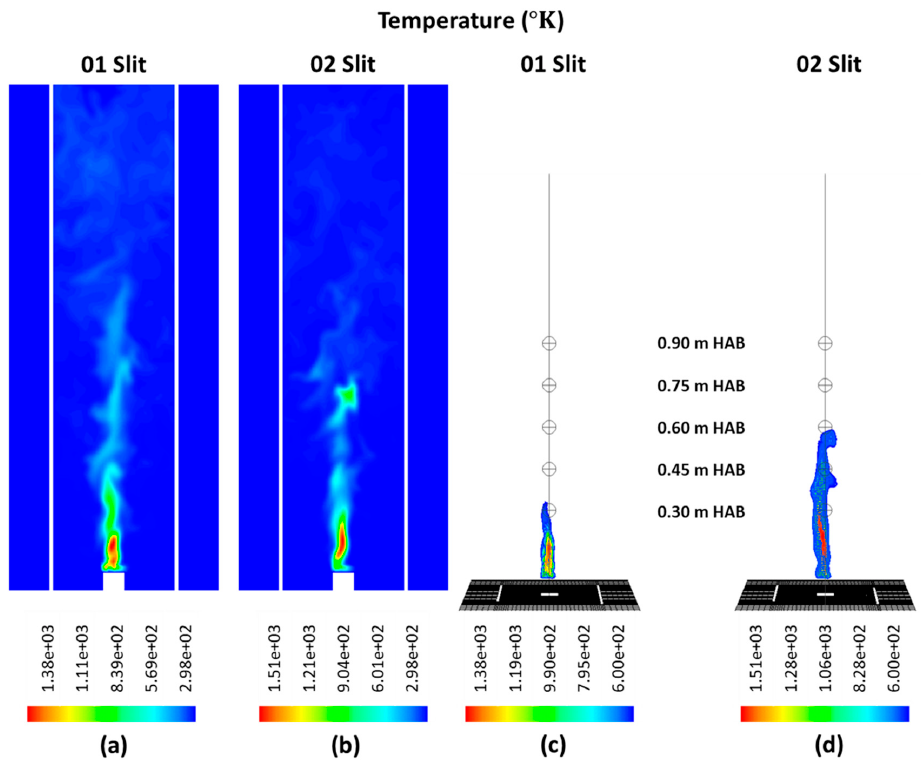
Figure 5. Temperature contour of a cross-sectional plane of the 01 slit case ( a ) and the 02 slit case ( b ), and the visible flame height of the fire whirl formulated by the 01 slit case ( c ) and the 02 slit case ( d ).